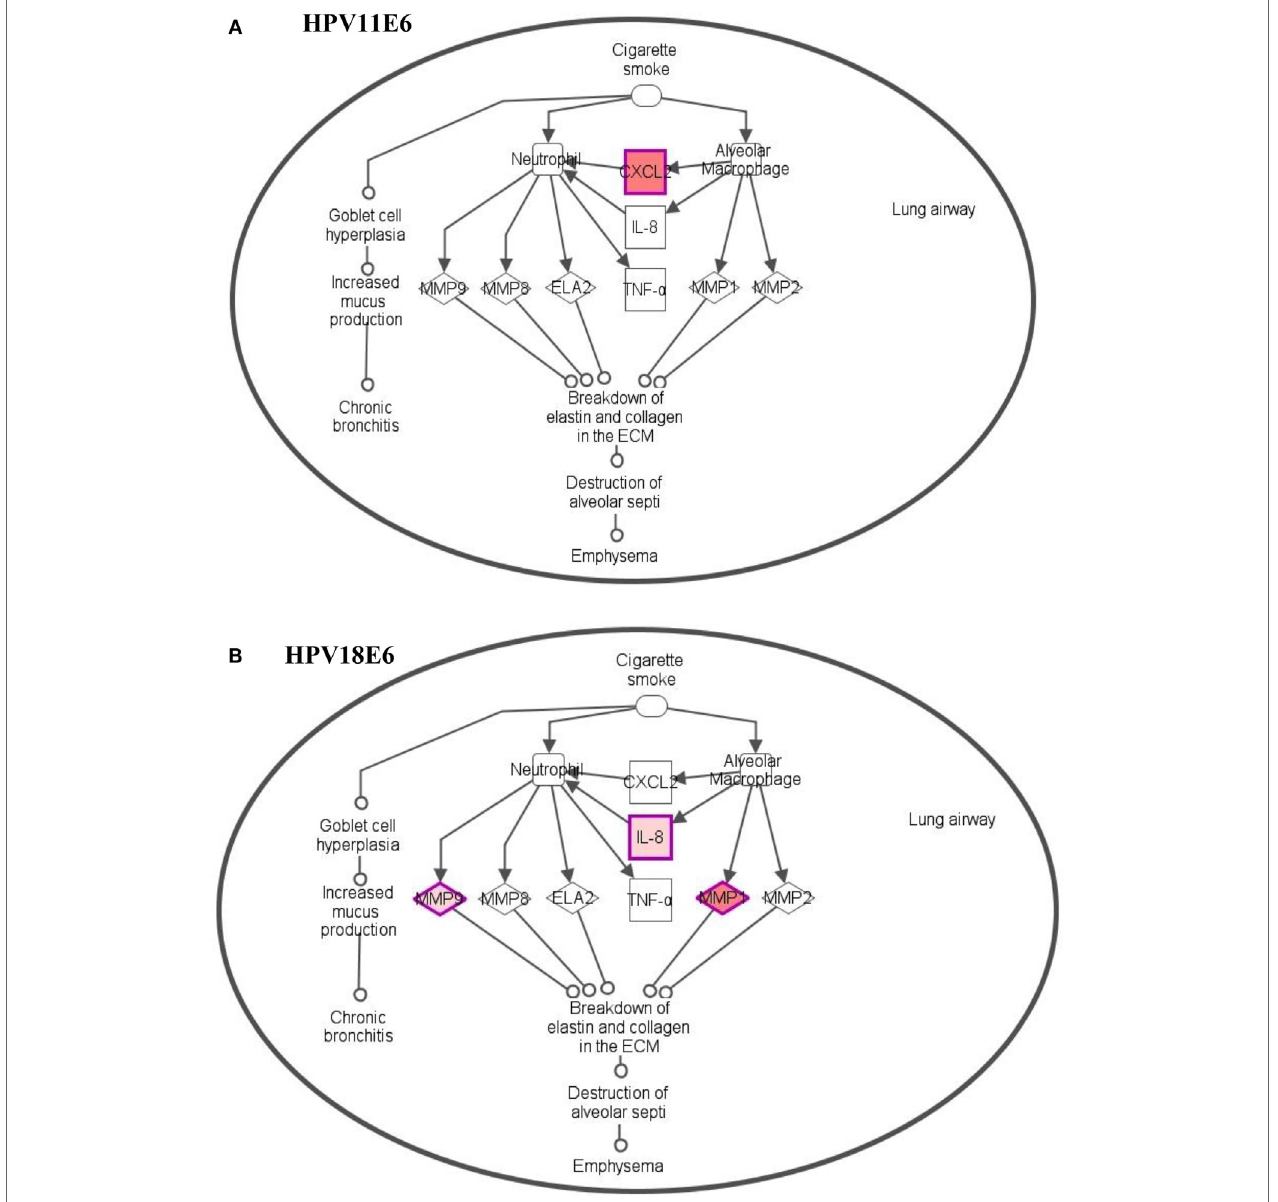
FigUre 7 | Differentially expressed genes induced in the chronic obstructive pulmonary disease canonical pathway. (a) HPV11E6 induced the upregulation of CXCL2 gene only, while HPV18E6 induced the upregulation of IL8, MMP1, and MMP9 genes (B) . Red shading indicates genes that are upregulated while the unshaded genes were not identified as differentially expressed by HPVE6 but were rather integrated into the computationally generated pathway on the basis of the evidence stored in the IPA knowledge memory indicating a relevance to this